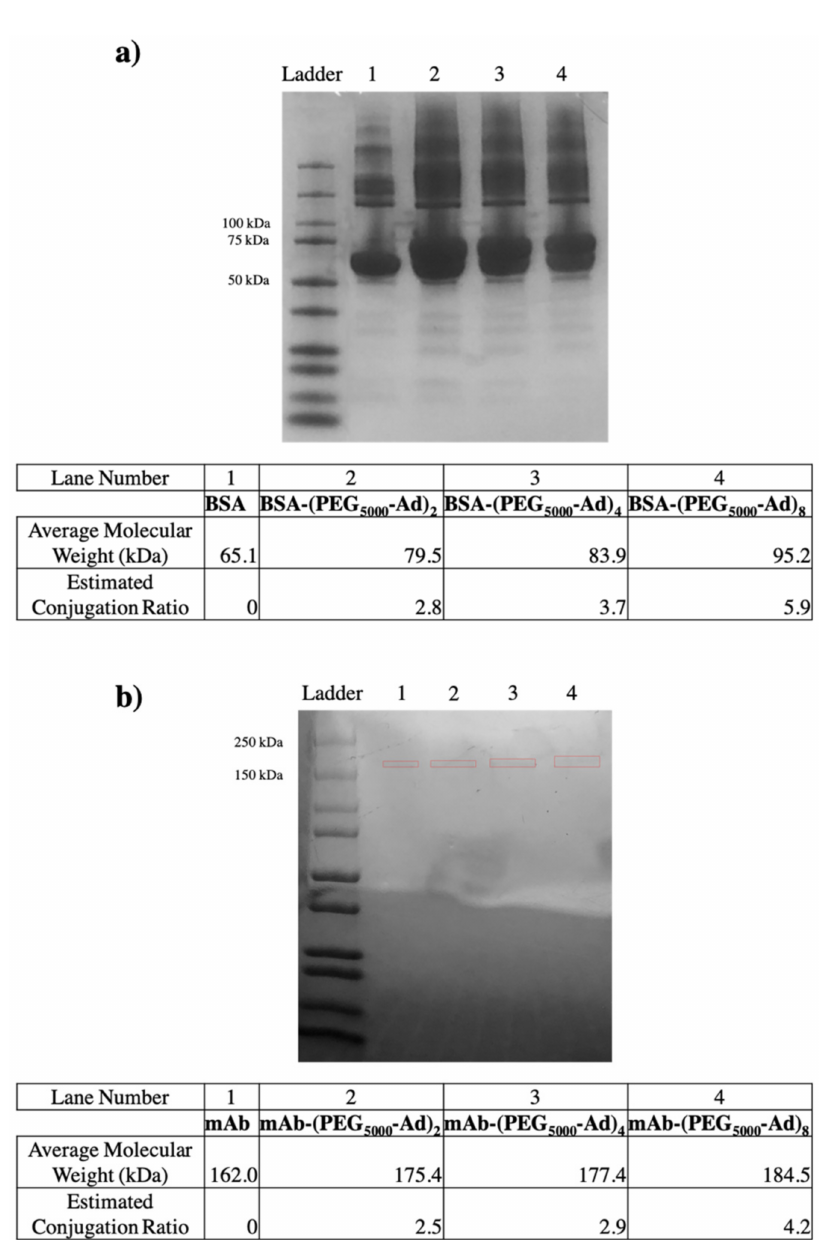
Figure 5. Nonreducing SDS-PAGE gel electrophoresis (12–20% Tris Glycine) of ( a ) BSA conjugates found between 79–95 kDa and ( b ) mAb conjugates found between 175–185 kDa. Average molecular weights were obtained based on ladder band locations in ImageJ. mAb bands were boxed in red to increase visibility, as loaded protein concentration was